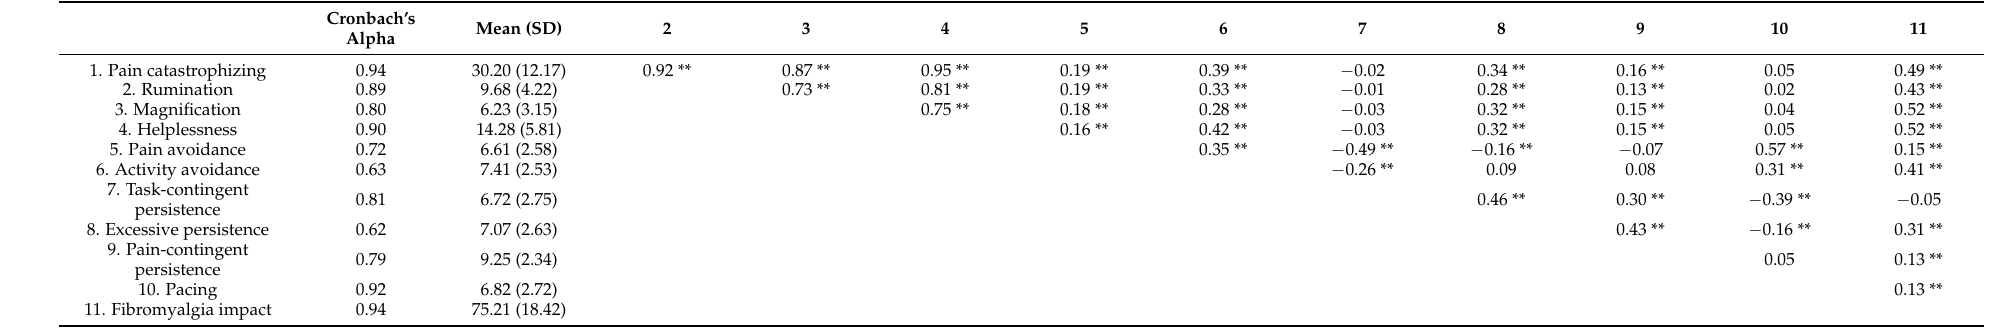
Table 2. Cronbach’s alpha, means, standard deviations, and Pearson correlations between study variables.